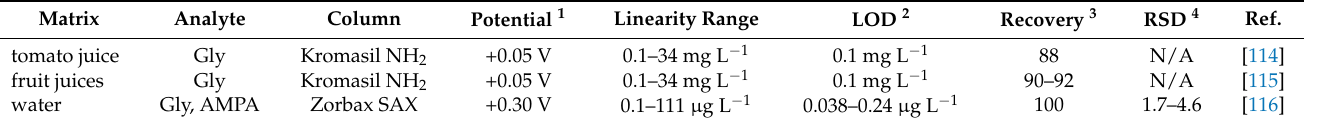
Table 10. HPLC-ED analysis performance in the analysis of glyphosate (Gly) and aminomethylphos- phonic acid (AMPA). The term “N/A” means the information is absent in the